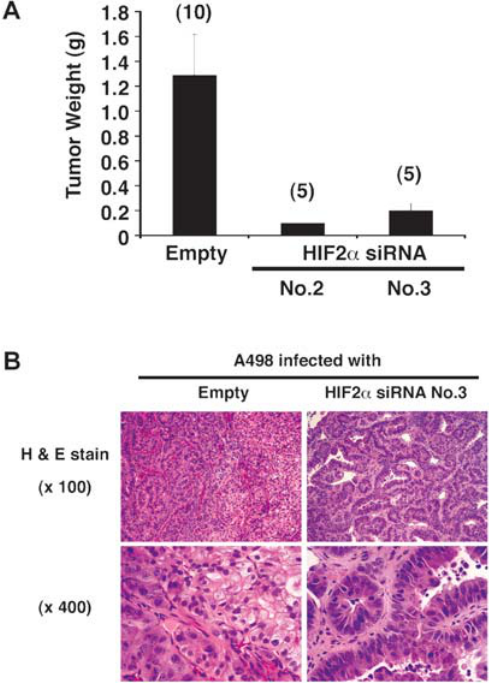
Figure 4. Tumor Suppression by HIF2 a shRNA Is Not Restricted to a Single Cell Line (A) Tumor weights approximately 8 wk after subcutaneous implanta- tion of A498 cells infected with the indicated retroviruses in nude mice. Number of tumors analyzed is shown in parentheses. Error bars ¼ one standard error. (B) Representative histological sections after staining with hematox- ylin and eosin of tumors formed by A498 cells infected with the indicated retroviruses. DOI: